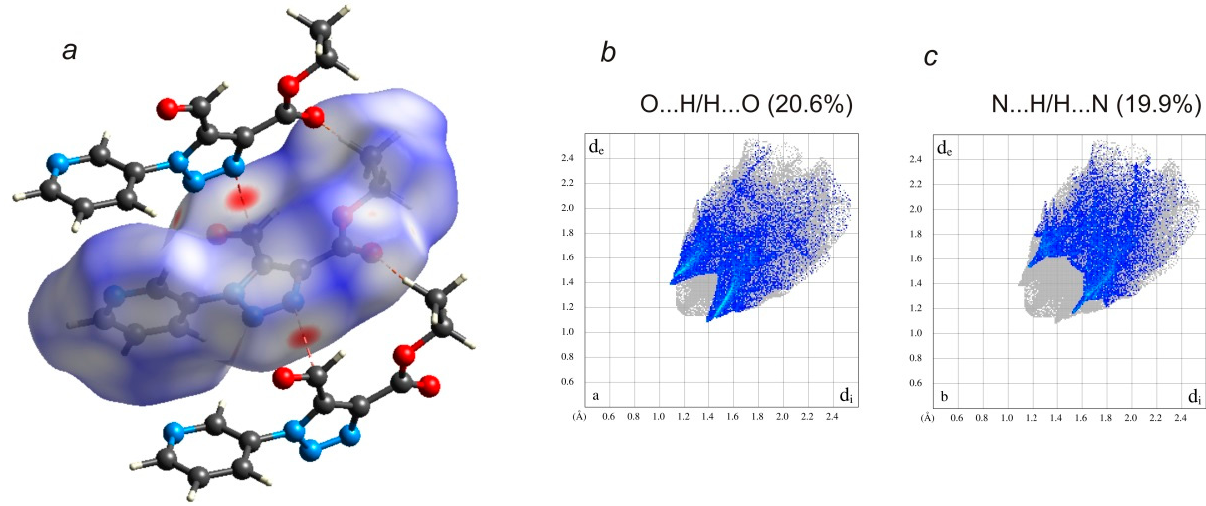
Figure 4. ( a ) Hirshfeld surface for the title molecule mapped with d norm over the range − 0.140 to 1.238 a.u. showing n → π * and C–H···O interactions. Fingerprint plots resolved into ( b ) O···H/H···O and ( c )